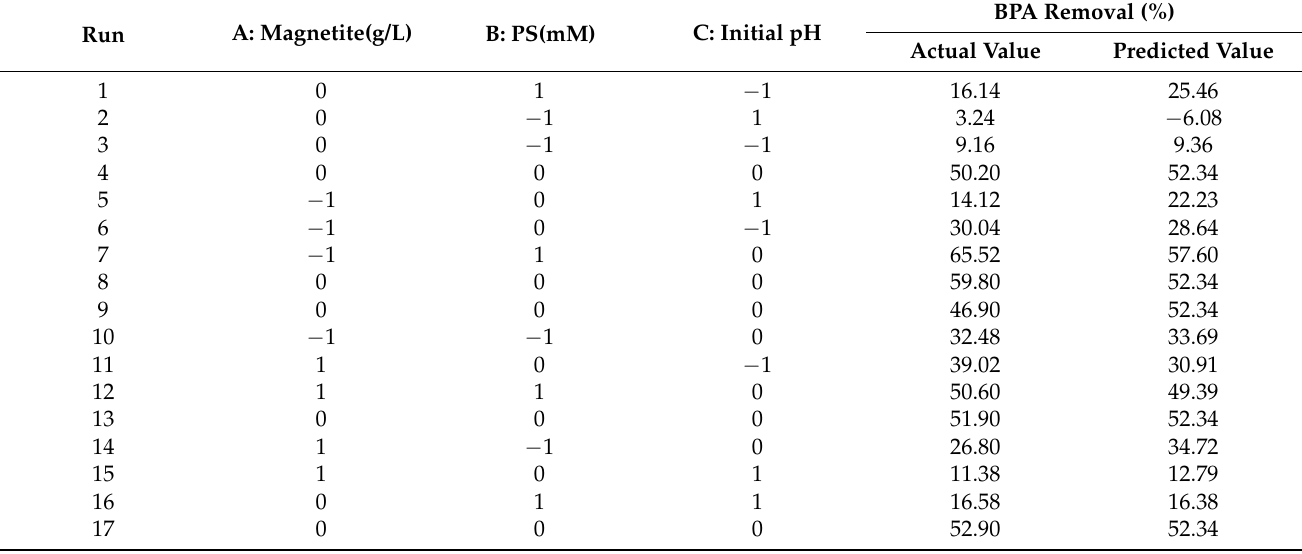
Table 3. Scheme and experimental results of response surface